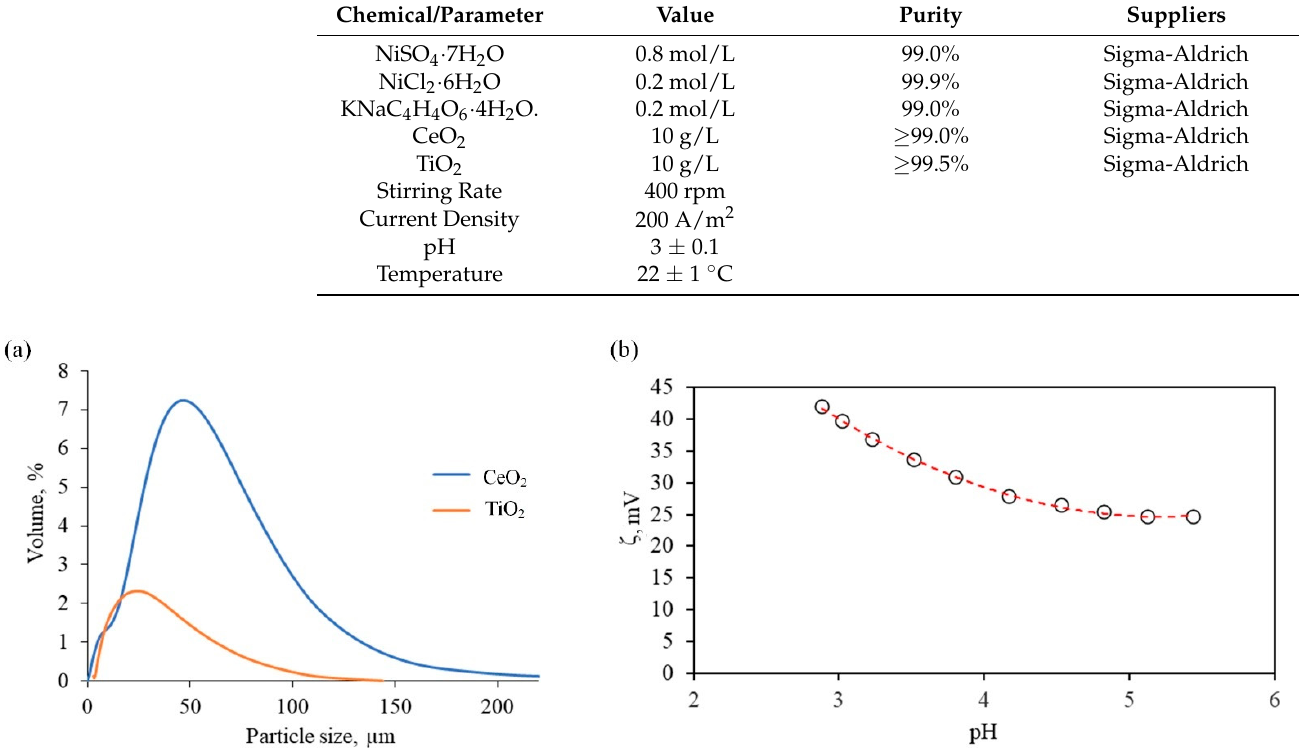
Figure 1. Particle size distribution for CeO 2 and TiO 2 ( a ) and ζ -potential versus pH for CeO 2 ( b ). The TiO 2 powder was predominantly in anatase phase (Figure S1) with the mean par- ticle size (Figure 1a) of 11 μ m (D 10 : 6.76; D 50 : 40.6; D 90 : 91). The CeO 2 powder revealed distinct intense lines corresponding to the fcc structure (Figure S1). The mean size of CeO 2 particles (Figure 1a) is 46.6 μ m (D 10 : 0.31; D 50 : 1.11; D 90 : 36.1). The measured mean size varied from